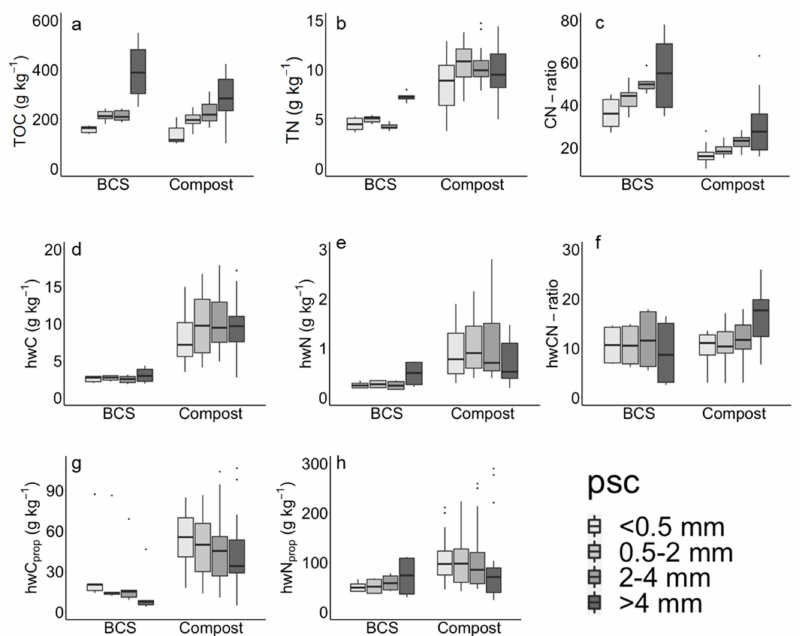
Figure 3. Conventionally analyzed samples of different organic amendments (OA) particle size classes (psc) ( n = 117) for ( a ) TOC, ( b ) TN, ( c ) CN-ratio, ( d ) hwC, ( e ) hwN, ( f ) hwCN-ratio, ( g ) proportion of hwC to TOC (hwC prop ), ( h ) proportion of hwN to TN (hwN prop